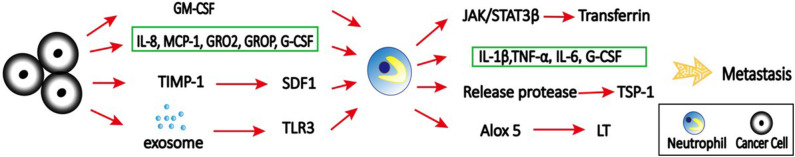
The role of neutrophils in pre-metastatic niche. Primary tumor cells secret various cytokines, chemokines, and signals to recruit neutrophils to distant organs to form pre-metastatic niche. For example, tumor cell secreted-IL-8, MCP-1, GROα, GROβ, and G-CSF can mobilize neutrophils to the pre-metastatic niche, which then facilitate colonization of tumor cells and subsequent metastasis; GM-CSF produced by tumor cells can induce transferrin synthesis in neutrophils through the Jak/Stat5β pathway; TIMP-1 increases SDF1 levels, which in turn promote recruitment of neutrophils to the liver to promote liver metastasis; tumor exosomal RNAs activate TLR3 to induce chemokines that are critical for neutrophil recruitment and lung pre-metastatic niche formation. At pre-metastatic niche, activated neutrophils produce IL-1β, TNF-α, IL-6, and Cox-2, and degranulate azurophilic granules to release elastase and cathepsin G, leading to degradation of the Tsp-1 and enhanced metastasis. In addition, neutrophils support metastatic lung colonization via ALOX5-dependent leukotriene (LT) synthesis/release.